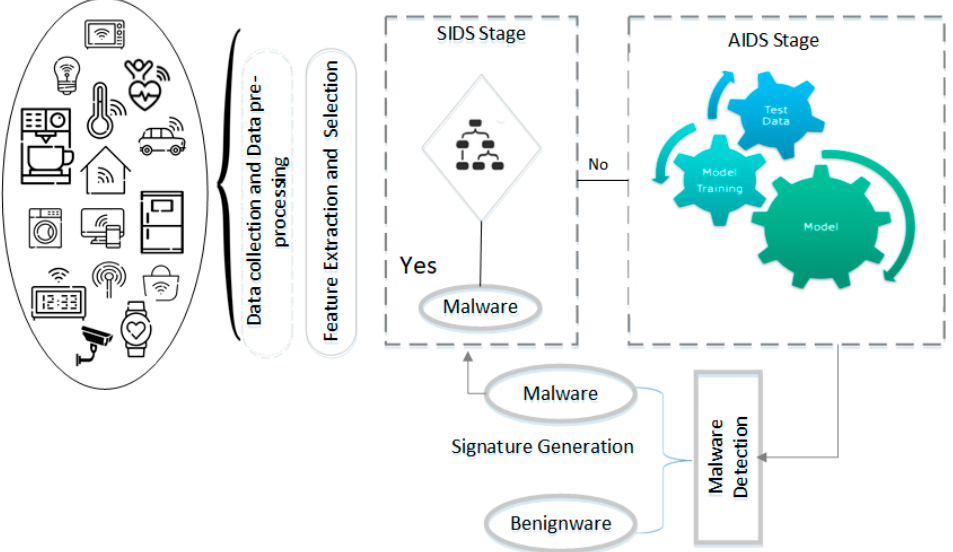
Figure 3. Hybrid Intrusion Detection System for the IoT ecosystem.